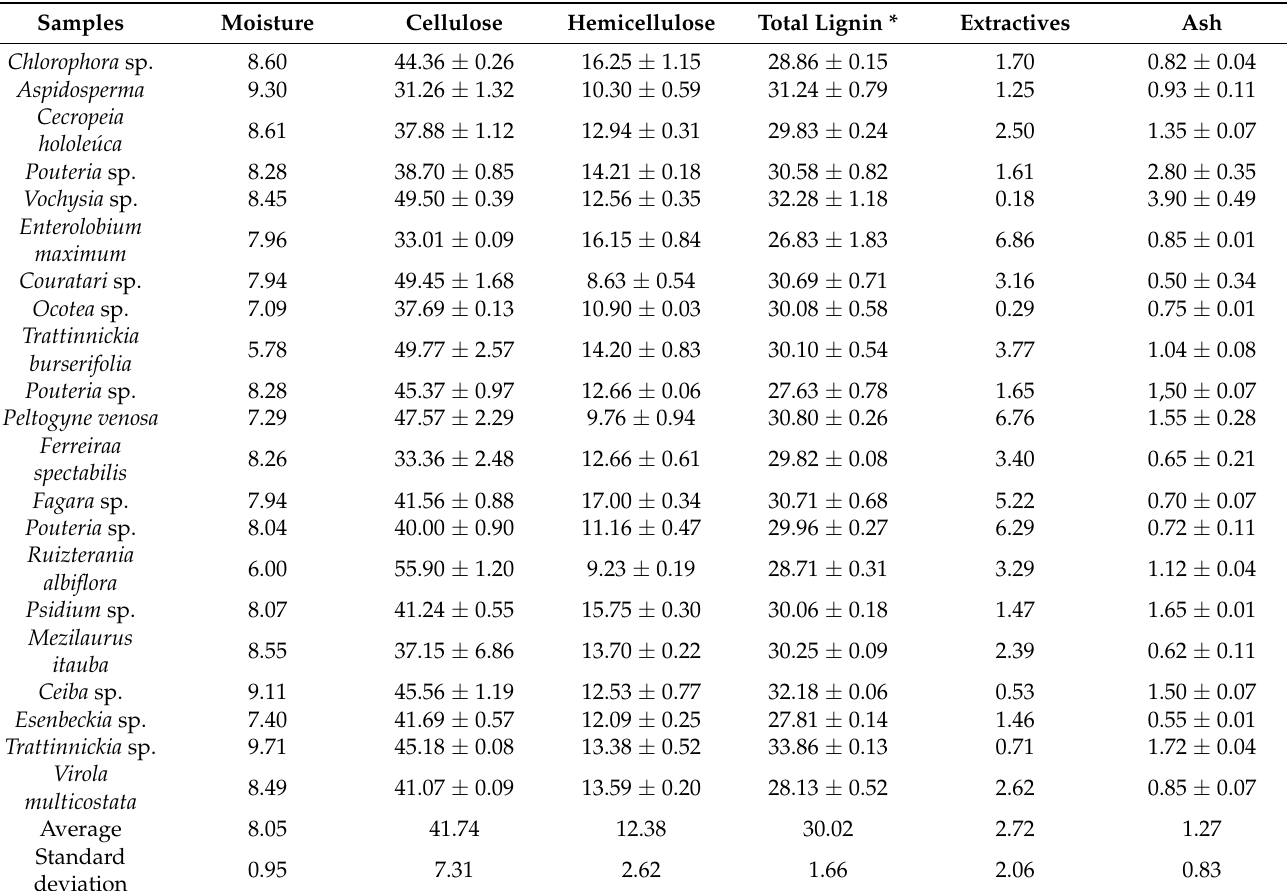
Table 2. Chemical composition of analyzed wood (% wt dry